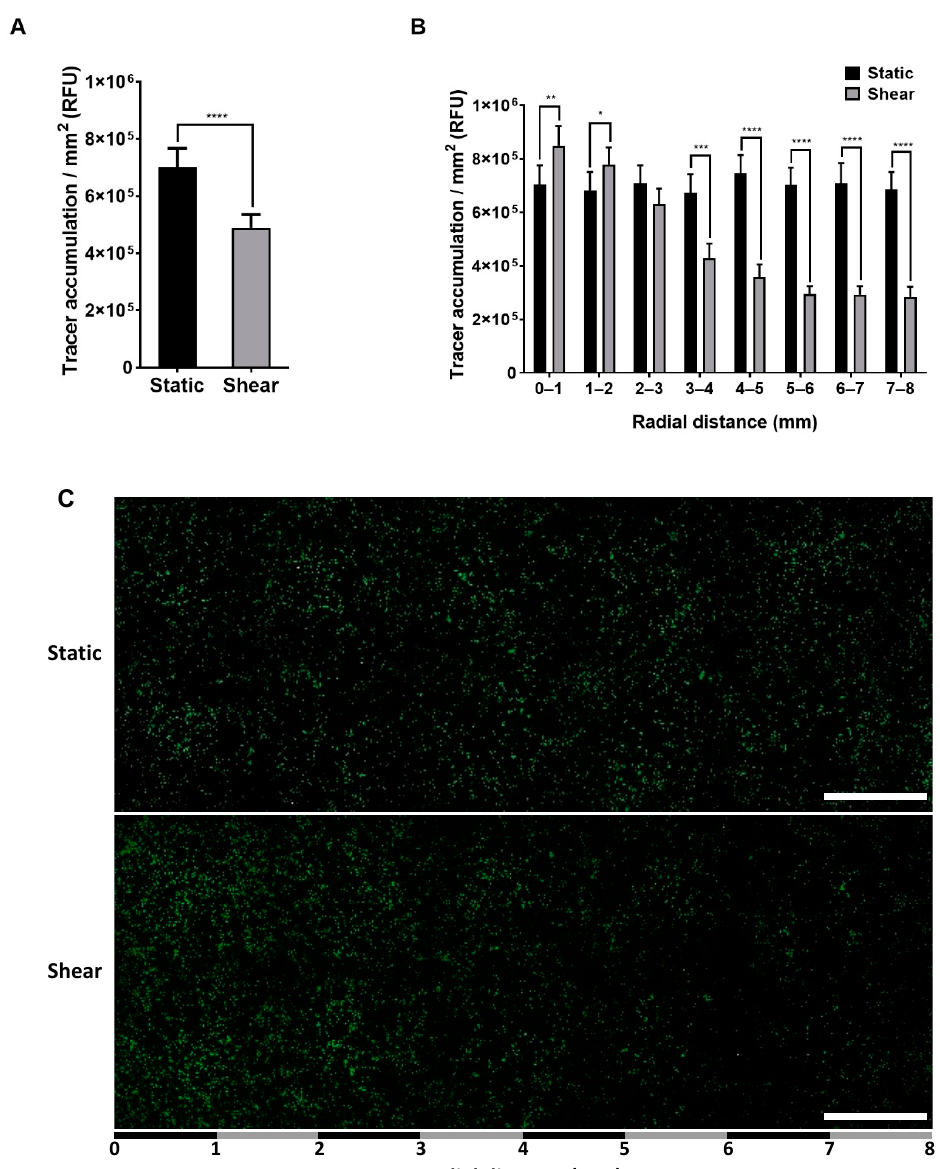
Figure 1. FITC-avidin accumulation, measured in relative fluorescence units (RFU), underneath static and sheared monolayers ( A ) for the entire well and ( B ) as a function of radial distance from the centre of the well. Mean + SEM, n = 8 isolations. ( C ) Representative tile scan of FITC-avidin accumulation (green spots) across a static well and a sheared well. Bar = 1 mm.